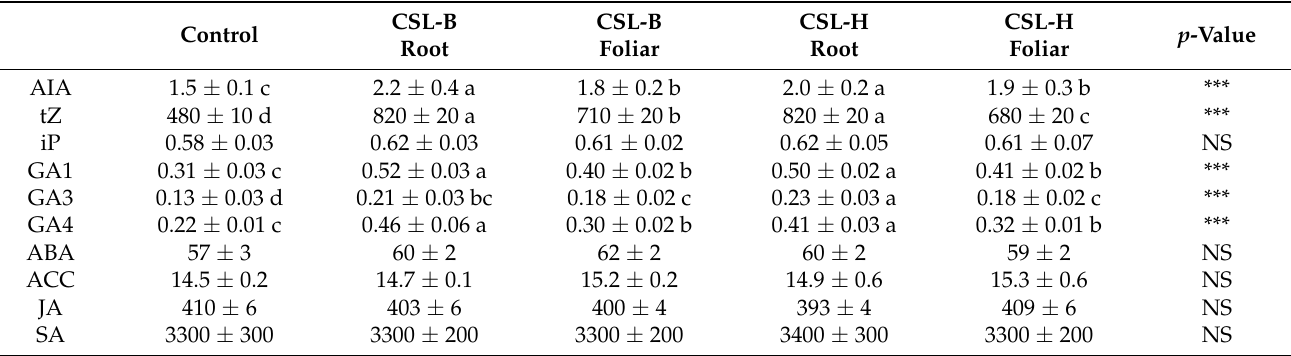
Table 5. Hormonal profile, 7 days after the last application of the treatments. IAA: indoleacetic acid (auxin); tZ: trans-zeatin; Ip: isopentenyl adenine; GA: gibberellin; ABA: abscisic acid;